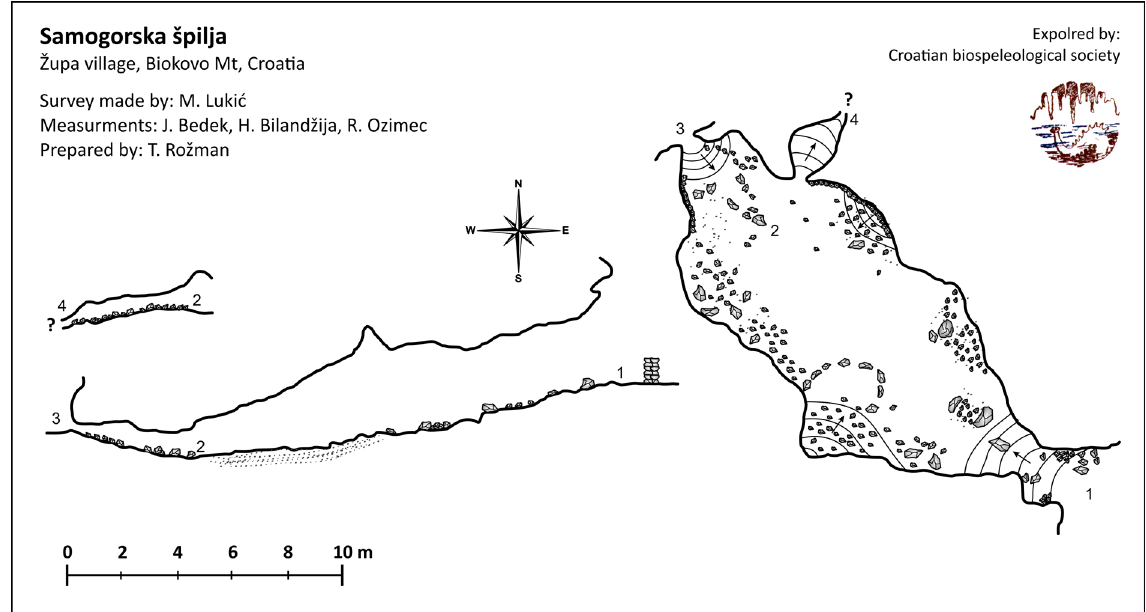
Fig 7. A survey of the K. deelemanae gen. et sp. nov. type locality: Samogorska